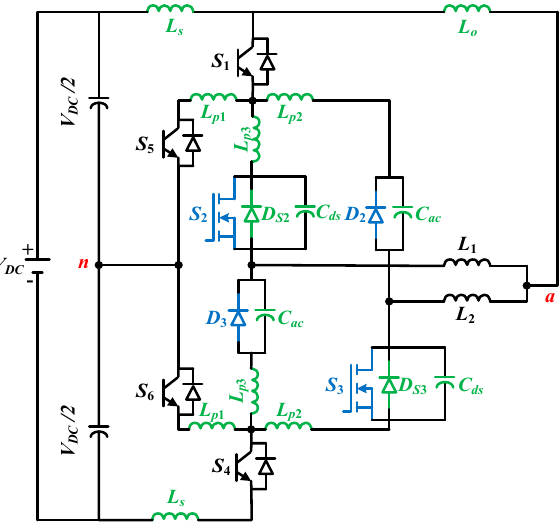
Figure 8. Core loss induced by the inductors under different switching frequencies.